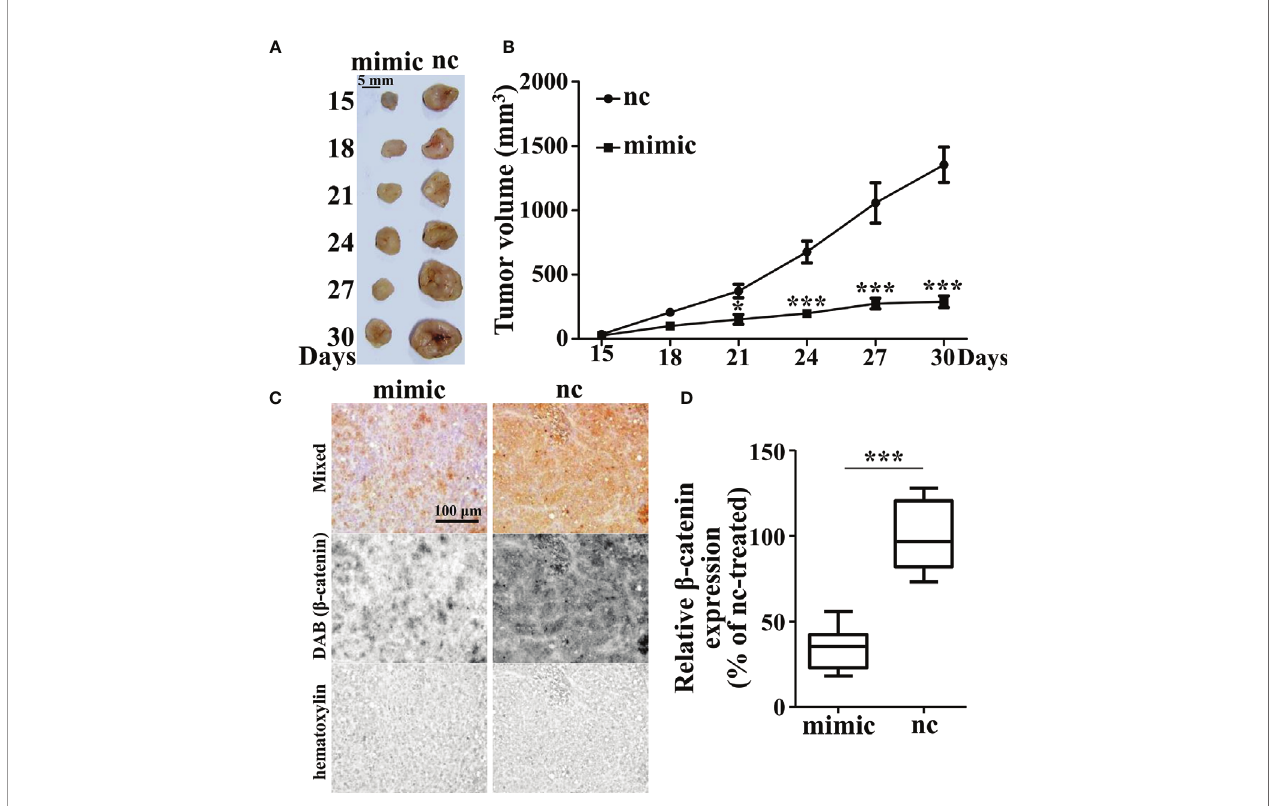
FIGURE 6 | Tumor growth is inhibited by miR-142-3p overexpression in xenograft mice. (A) Tumor xenograft mice model. HT29-nc and HT29-miR-142-3p mimic cells were injected into the hindlimbs of nude mice (n = 6 at each time point). (B) Summary of tumor volume measurement. (C) Immunohistochemistry analysis of b - catenin expression in the tumor regions of both nc- and mimic-injected nude mice. Scale bar, 100 m m. (D) Summary of (C) . All data are shown as means ± SD. * and *** represent signi fi cant difference with p < 0.05 and 0.001,